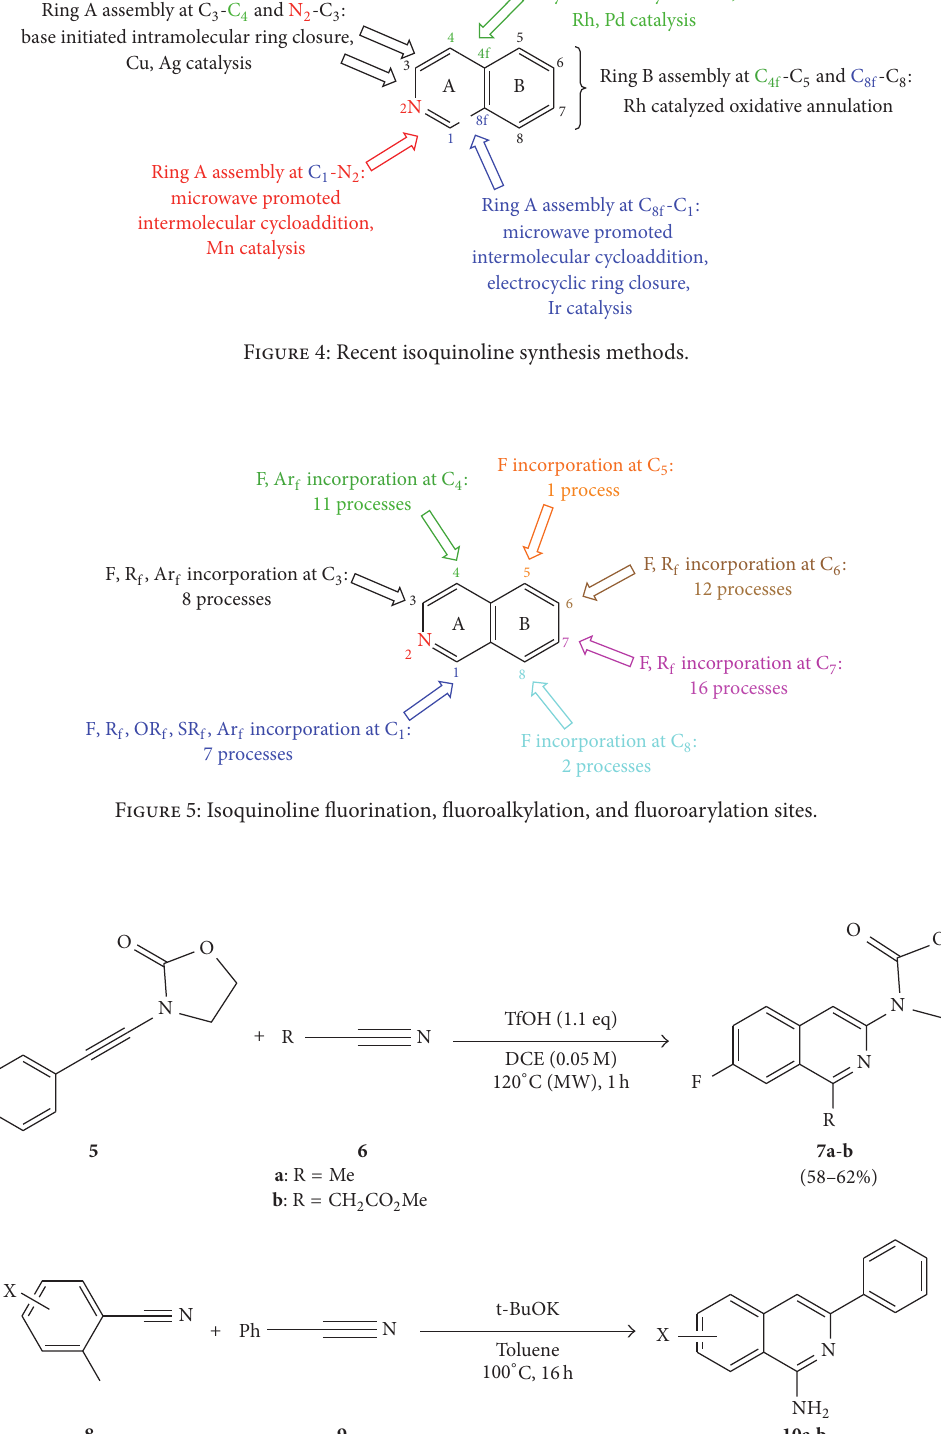
a : X = 4-F b : X = 5-F Scheme 3: Preparation of 6- and 7-fluoroisoquinolines via ynamide-nitrile and nitrile-nitrile